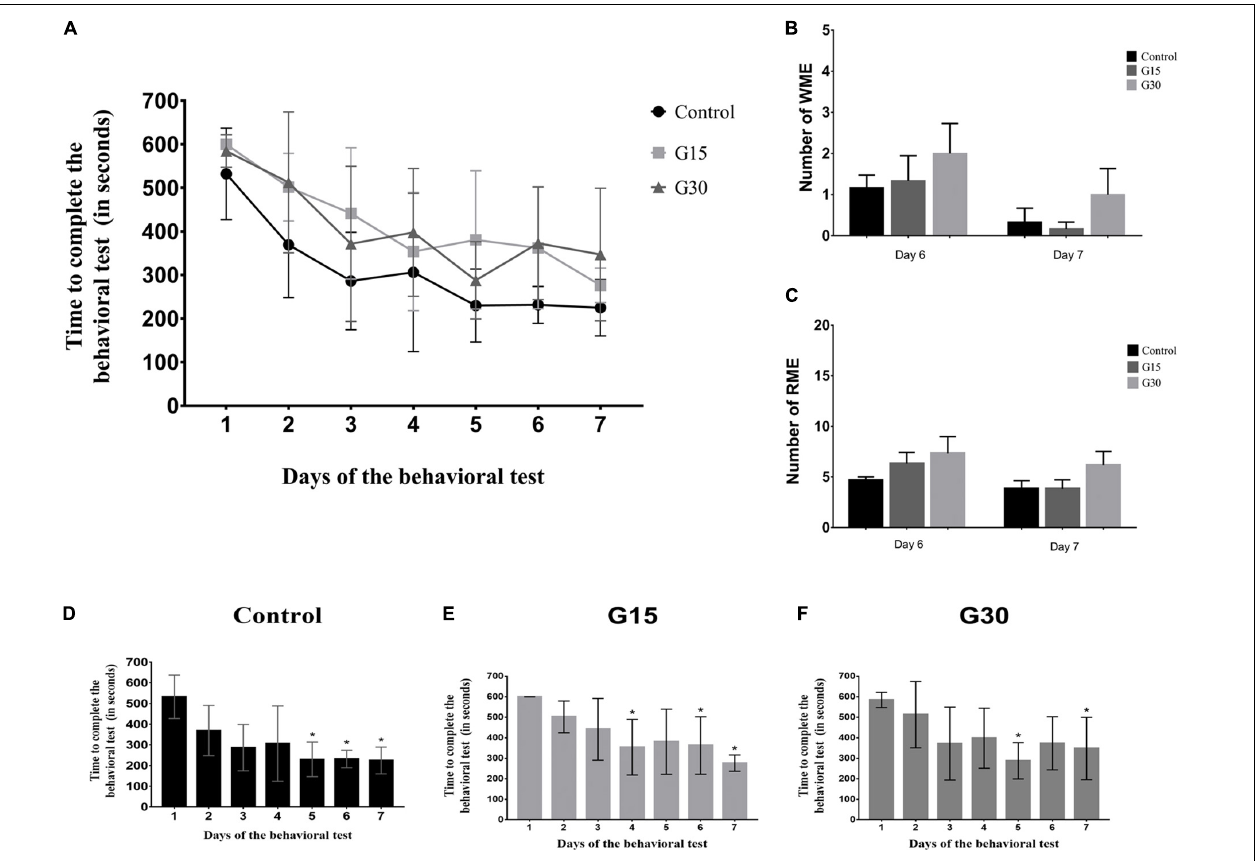
FIGURE 5 | Quantitative data for learning and memory assessment. (A) The average time of exploration of the eight-arm radial maze per group in each experimental day. (B) Quantification of working memory errors (WMEs). (C) Quantification of reference memory errors (RMEs). (D–F) Times for test performance in each experimental day for all groups. No statistical differences were observed after comparisons ( p > 0.05, Kruskal–Wallis with Dunn’s post hoc test). Asterisks in (D–F) indicate statistically significant improvement compared to day 1 ( p <